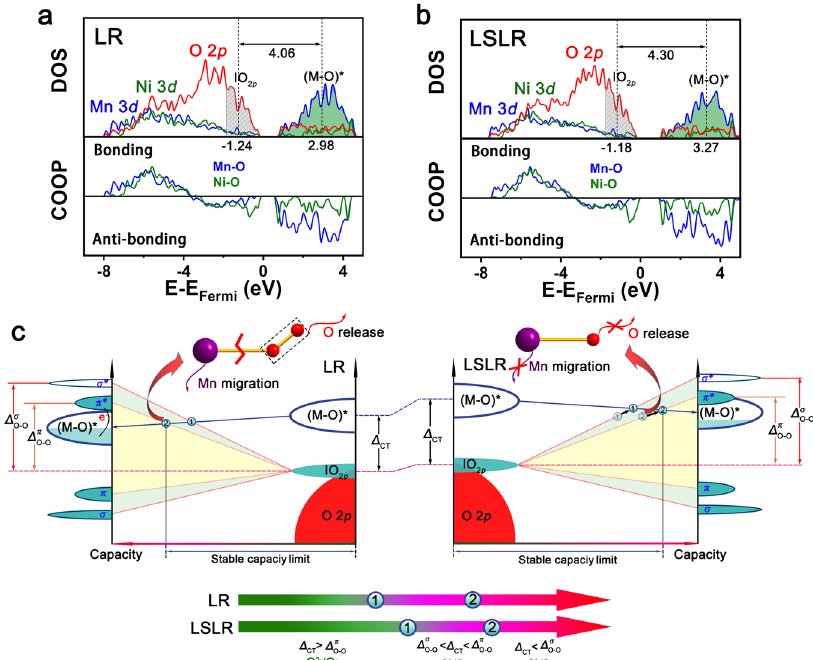
Fig. 5 First-principle calculations of LR and LSLR. a , b Calculated partial DOS for O/Mn/Ni and COOP analysis of Mn – O/Ni – O in LR ( a ) and LSLR ( b ). c Sketch of the oxidation process in charge transfer on metallic and anionic bands for LR and LSLR. Source data are provided as a Source Data fi